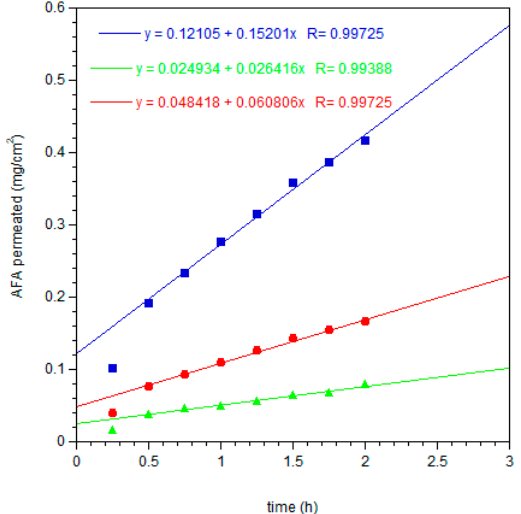
Figure 11. Linear fit at the steady state of AFA permeation per cm 2 of porcine sublingual mucosa, from AFA100 film , AFA300 film, and ▲ solution.